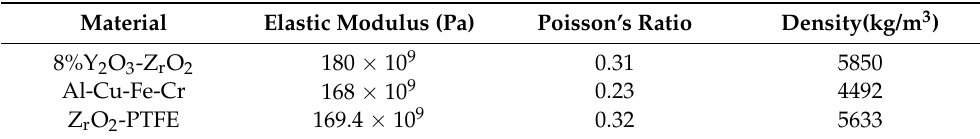
Table 4. Hard coating material parameter table.